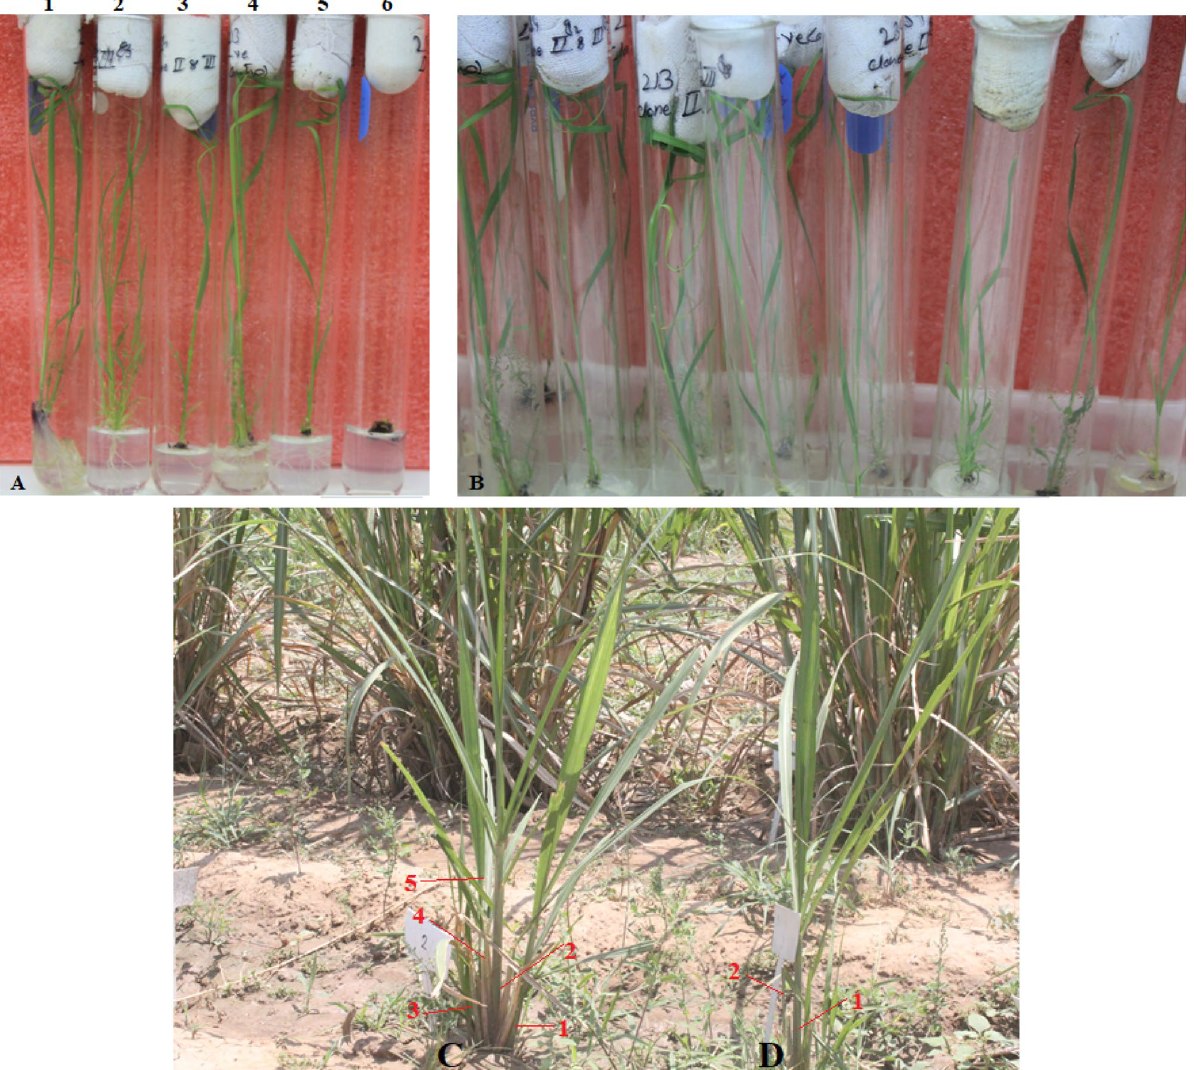
Figure 4. ( A ) Some selected transgenic lines were screened under hygromycin (100 mg/ml) selection media to evaluate putative transgenic lines accompanied with ThSyGII (CEMB-SIG2) on MS test tubes. Transgenic line 1–5 withstood hygromycin selection medium, survived and showed robust growth under selection medium. The line labelled with 6 is non-transgenic which could not tolerate hygromycin supplemented selection media ( B ). The Fig. 4B indicated control sugarcane plants without any selection media which showed maximum growth in the same conditions as provided to putative transgenic lines but without any inclusion of selection drug. The figure was cropped to enhance focus and to remove distractions in the figures. Different figures were taken in different numbers and in various groups but all shown plants in figures were captured at the same day